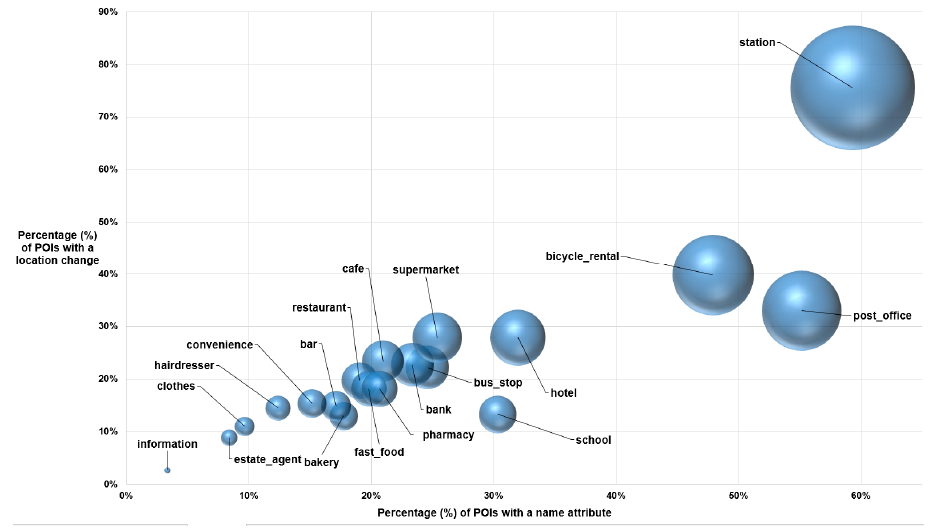
Figure 2. Percentage of POIs that had a name ( x -axis) and a location ( y -axis) change. The size of the bubble corresponds to the intersection of the two changes.